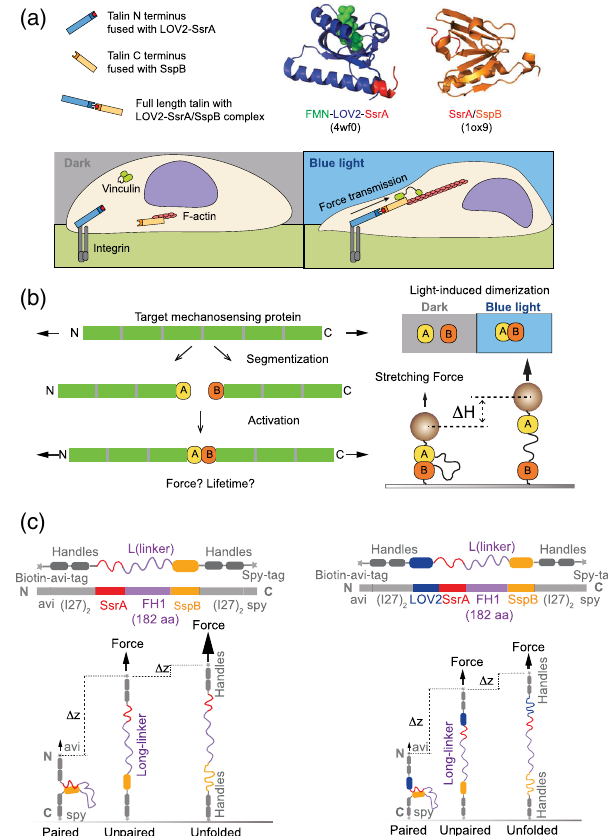
FIG. 1. Illustration of potential implementation of optogenetic modulation. (a) Illustration of a talin-mediated mechanotransduc- tion linkage in a cell. The truncated talin molecule segments (talin N terminus and talin C terminus) are fused with the dimerizing domains LOV2-SsrA and SspB, respectively (top left). The crystal structures of LOV2-SsrA (PDB: 4wf0) and SsrA-SspB (PDB: 1ox9) are also shown (top right) [7,8]. (b). Left: Illustration of the potential implementation of the molecular optogenetic switch systems to connect the two segments of a truncated protein. Right: Illustration of the experimental design of the single-molecule stretching on the light-sensitive dimers. (c). Experimental design of single-molecule SsrA/SspB (left) and LOV2-SsrA/SspB (right) constructs. Top: Single-molecule constructs (N-to-C terminus): avi-tag for biotinylation, two repeats of the titin Ig 27th domain (I27), SsrA (left) or LOV2-SsrA (right), a long flexible unstruc- tured peptide chain FH1 domain, SspB, two repeats of I27, and spy-tag [9] for the specific spy-catcher attachment. Bottom: A single-molecule construct is specifically tethered between a cover slip surface and a magnetic bead with an approximately 600-bp DNA handle (more details in Sec.